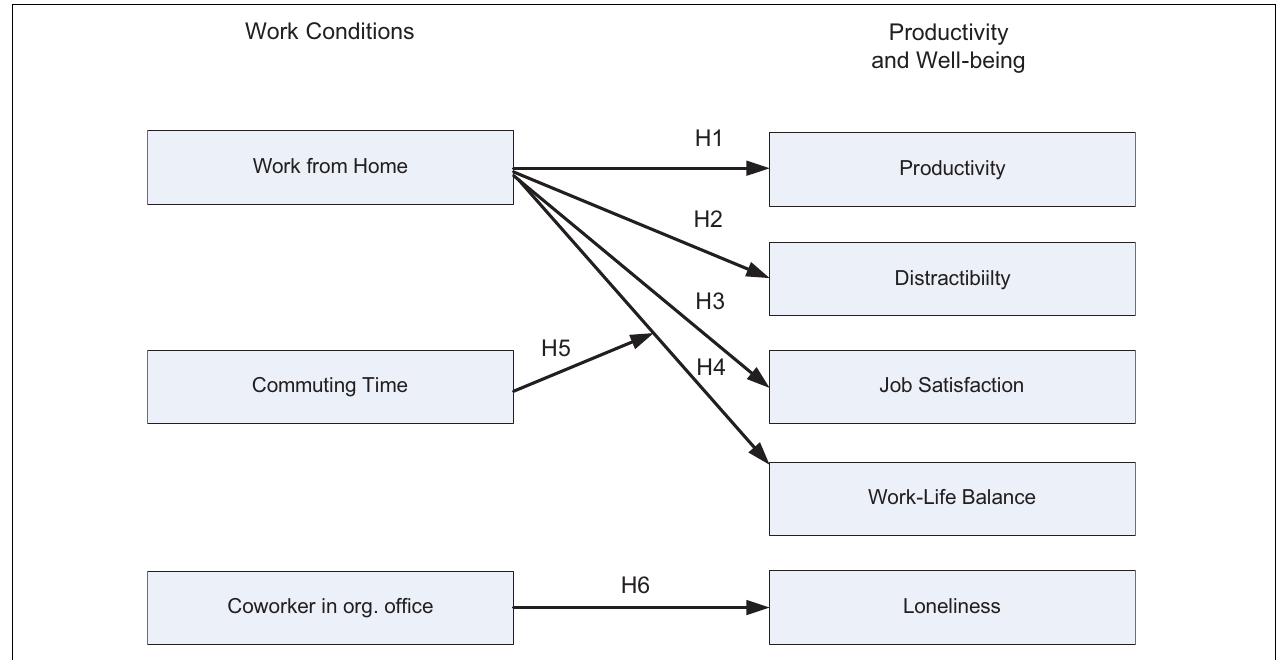
FIGURE 1 | Study hypotheses on working conditions during the coronavirus disease 2019 (COVID-19) pandemic and self-reported productivity, distractibility, and indicators of wellbeing.